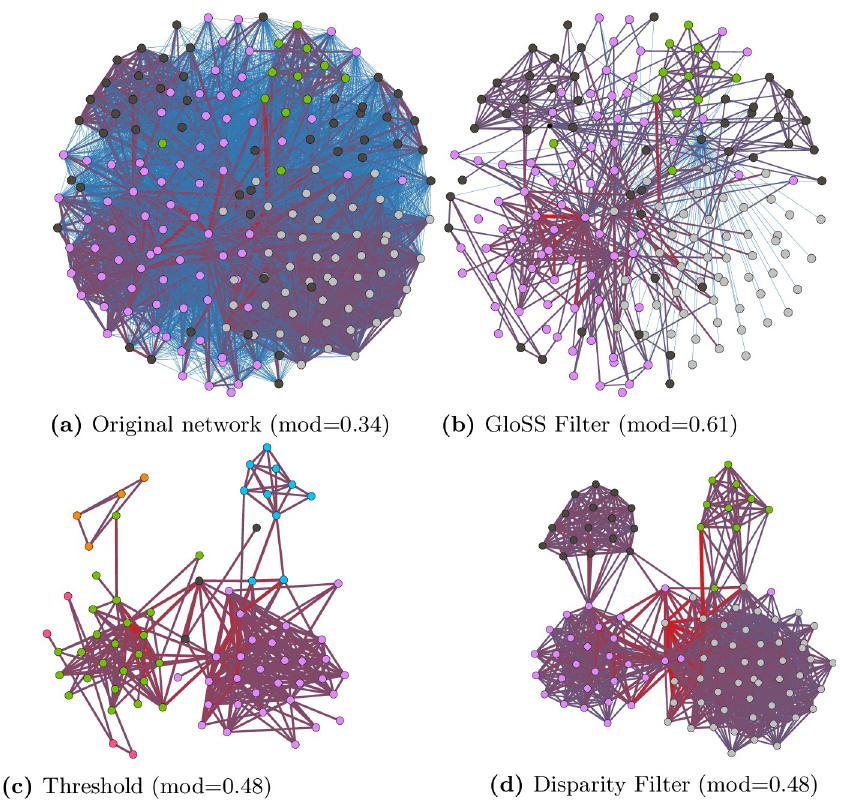
Fig 2. Example network and the backbones extracted from it by three different methods (modularity values presented within parentheses). Edge thickness represents edge weight and nodes’ color possible coordinated users’ communities. Node position is the same as in the original